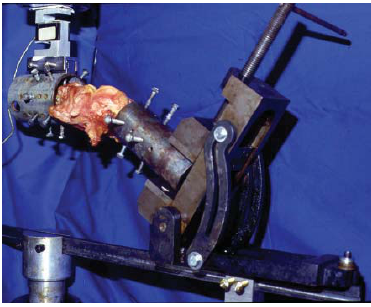
Figure 1 - Adjustable device with knee in 30º